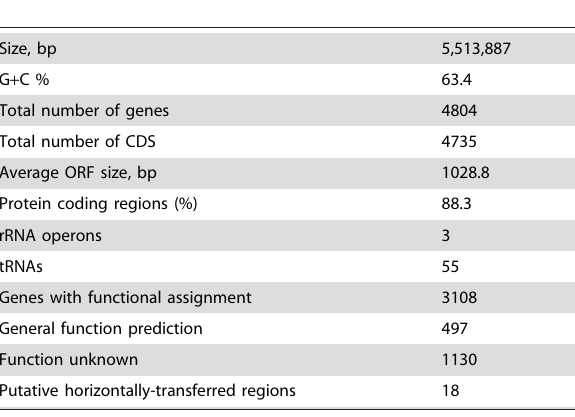
Table 1. General features of the genome of Herbaspirillum seropedicae